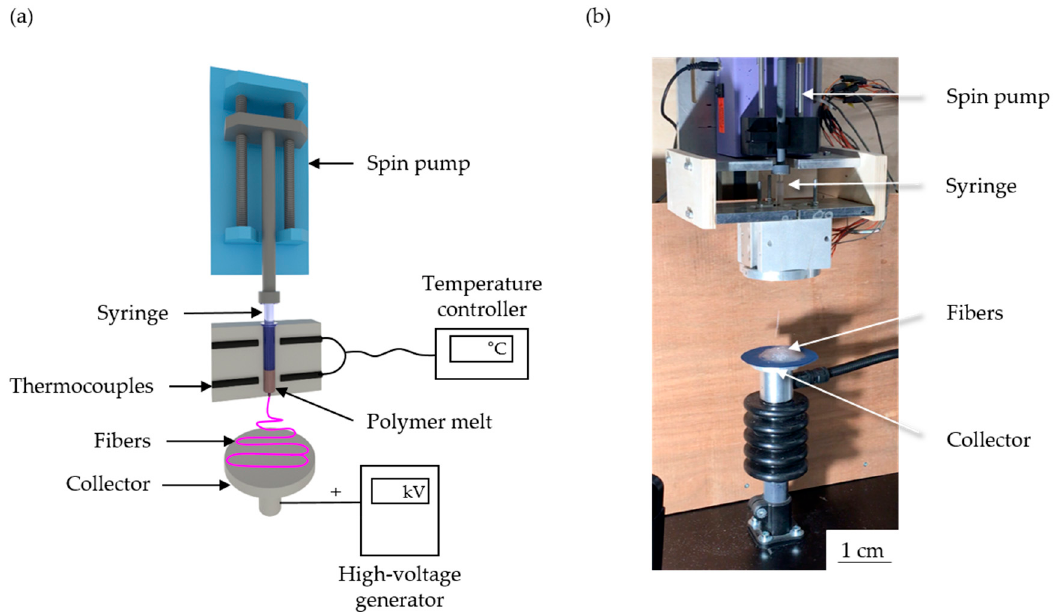
Figure 1. Schematic illustration ( a ) and picture ( b ) of our melt electrospinning equipment.